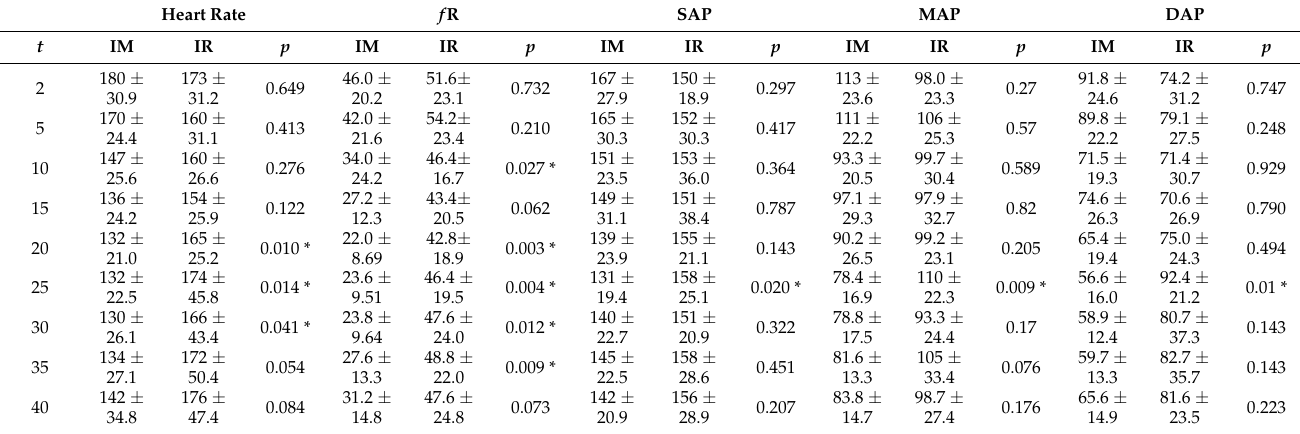
From left to right: vital signs and, respectively, p value ( p ) at each time of control IMG and IRG: heart rate (HR), respiratory rate ( f R), systolic, mean and diastolic pressure (SAP, MAP, and DAP). Statistically significant values with relative p value (significant level < 0.05) are marked with an asterisk